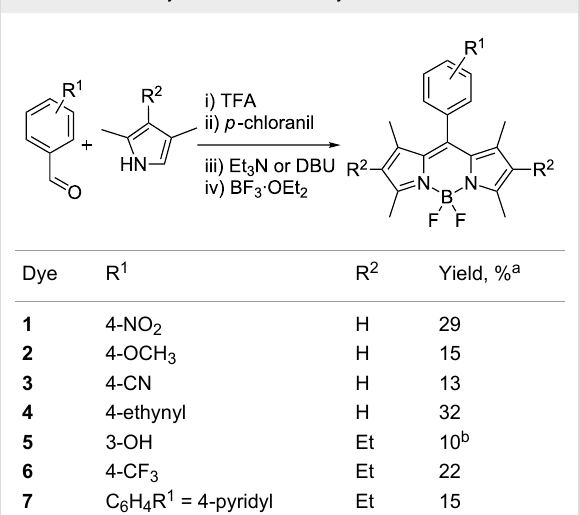
Table 2: 5-minute synthesis of BODIPY